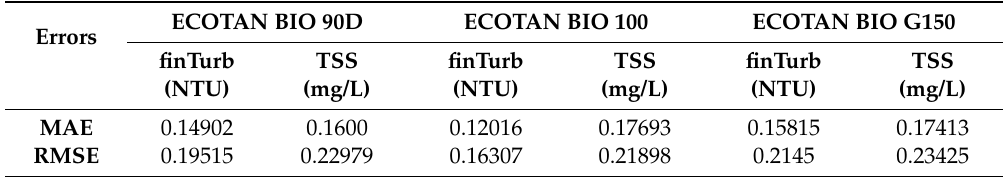
Table 13. Results of the errors in finTurb and TSS using the second-order regression models.